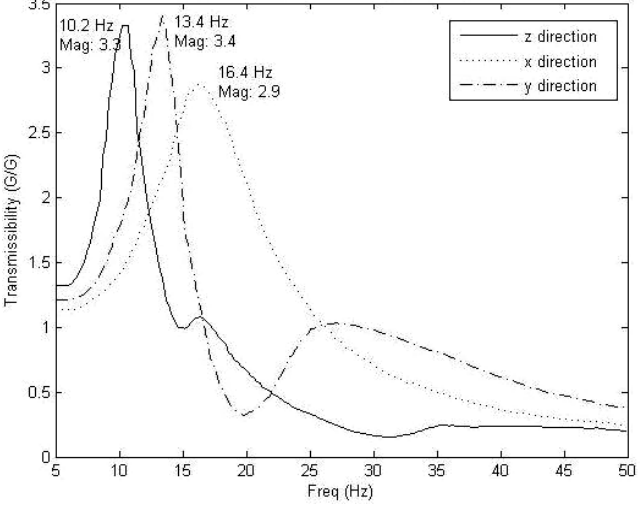
Fig. 16. Transmissibility plot for vibration isolation system II.